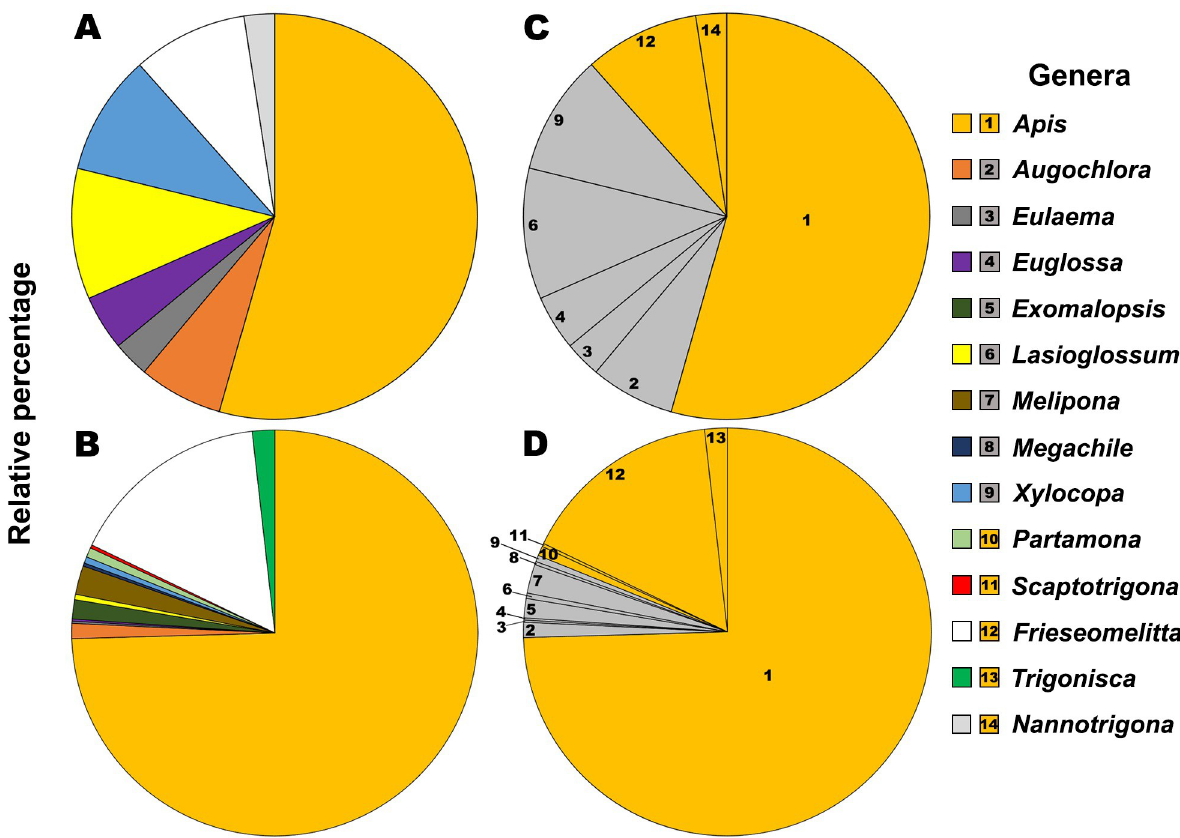
Fig 1. Pie charts showing the relative proportion of bee genera (in different color) visiting eggplant (A) and annatto (B) flowers in Yucata´n, Mexico. In pies (C) eggplant and (D) annatto, the genera are classified as sonicating (in grey) and non-sonicating (in orange), to represent the relative proportions of both bee types in each crop. Numbers on pies indicate the different